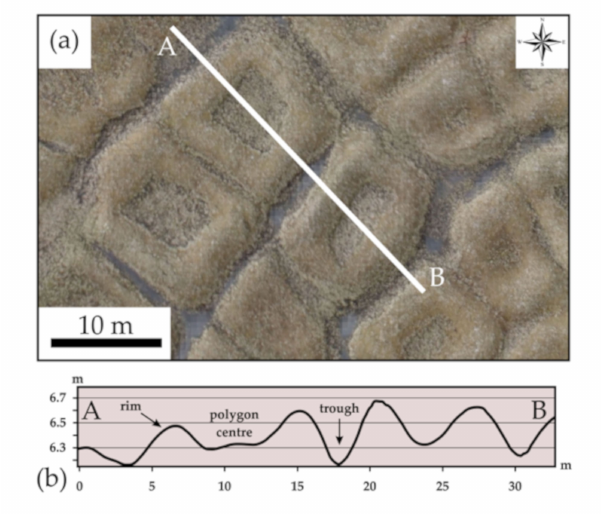
Figure 5. Intermediate-centered polygons (ICP) with water-filled troughs in ( a ) an orthophoto map that is mixed with a GSR map. We obtained a topography profile ( b ) by using ArcGIS. This profile shows troughs, which subsided below the polygon centers and elevated rims.